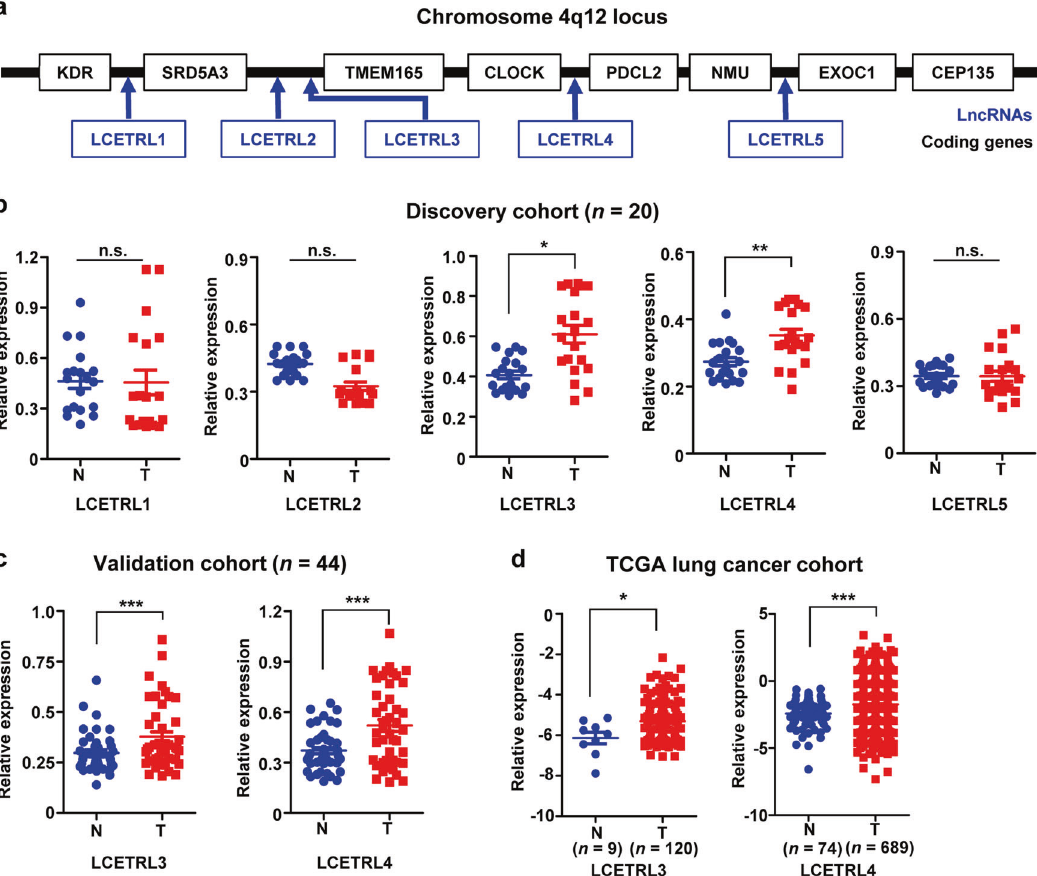
Fig. 1 LCETRL3 and LCETRL4 are two signi fi cantly upregulated lncRNAs in NSCLC specimens. ( a ) Five candidate lncRNAs (LCETRL1, LCETRL2, LCETRL3, LCETRL4 and LCETRL5) locate at 4q12. ( b ) Relative expression of fi ve candidate lncRNAs in paired NSCLC and normal tissues of Discovery cohort ( n = 20). ( c, d ) Signi fi cantly elevated expression of lncRNAs LCETRL3 and LCETRL4 in NSCLC specimens of Validation cohort ( n = 44) and TCGA lung cancer tissues compared to normal tissues. Two-tailed paired t test or two-tailed unpaired t test, n.s., not signi fi cant, * P < 0.05, ** P < 0.01, *** P <